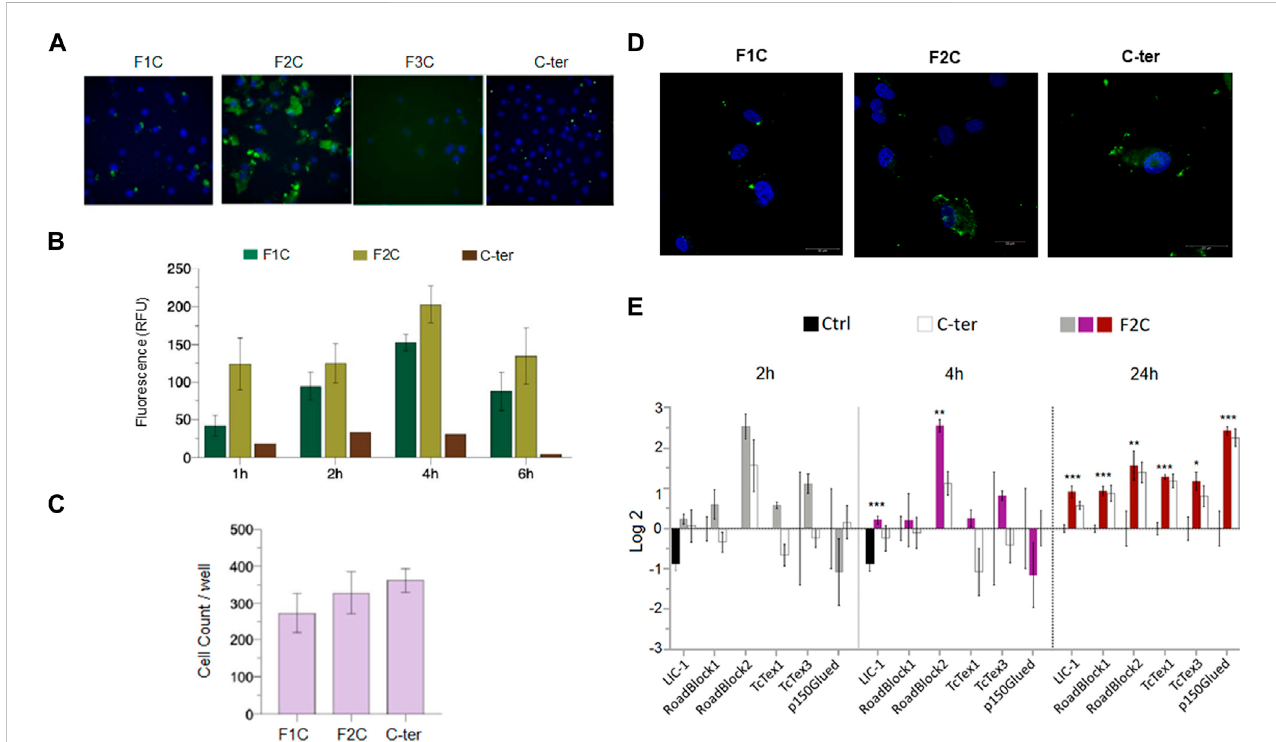
FIGURE 8 F2C, a C-ter derived fragment uptaken by tumor cells and its action on dynein chains. SK-MEL-28 cells were treated with fl uorescent peptides F1C, F2C, F3C and C-ter (all at 10 µM) for indicated times. After 6h, uptake was evaluated. (A) Representative fi gures after 6 h of treatment. (B) Quanti fi cation of relative fl uorescence units (RFU). (C) Cells counts per well. (D) Confocal analysis. (E) Cells were treated with F2C or C-ter (5 µM) at the indicated times and levels of gene expression dynein chains were evaluated by real-time PCR. Green fl uorescence was monitored by a Molecular Devices ImageXpress Micro Confocal plate-scanning microscope or by Confocal microscope TCS SP8 (Leica Microsystems, GmbH Mannheim, DE). RFU and cells count were de fi ned using MetaXpress software (Molecular Devices, Sunnyvale, CA). Values are mean ± SD of three independent experiments. * p ≤ 0.05; ** p ≤ 0.01 and *** p ≤